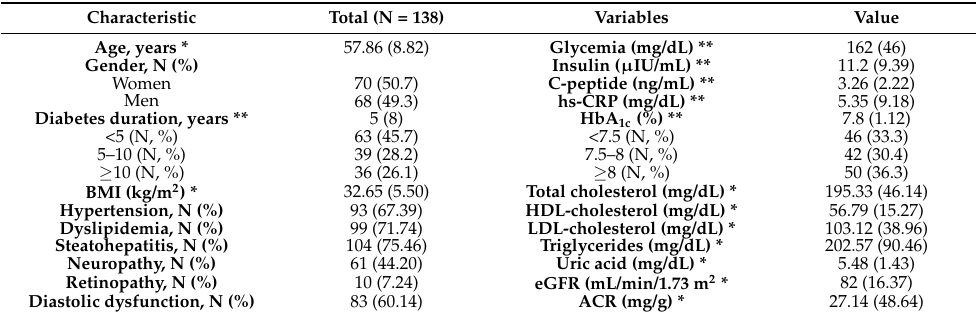
Table 1. Patients’